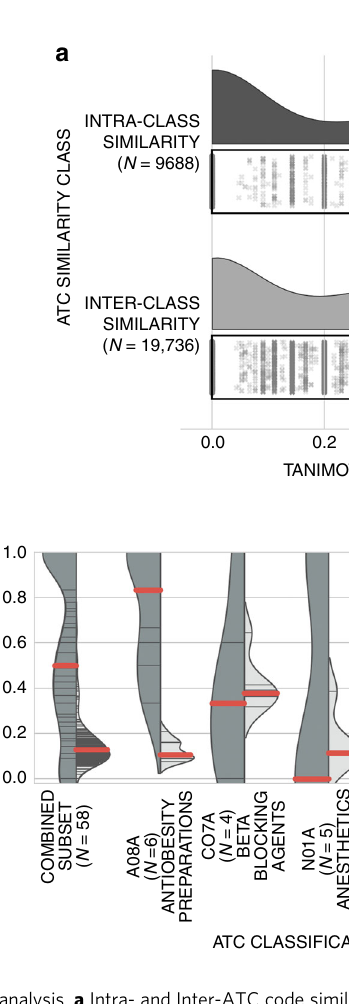
Fig. 2 Neurochemical similarity analysis. a Intra- and Inter-ATC code similarity of neurochemical response patterns across brain regions. Distributions are shown using kernel density estimation (KDE) with median similarities identi fi ed by the red marker and via the underlying boxplot with the notch denoting median, the outer boxes denoting the lower and upper-quartile ranges and the jitter scatter plot outlining the underlying observations. Compounds within the same ATC classi fi cation (intra-similarity) exhibit higher median similarity in neurochemical response than between ATC codes (inter-similarity), with a median response fi ngerprint Tanimoto coef fi cient ’ s of 0.43 and 0.33, respectively. The underlying distributions are statistically different with a two-sided Kolmogorov – Smirnov test p -value of 6.31 e-56 . However, the similarity distributions are quite wide (interquartile ranges span 0.0 to 1.0 for both intra- and inter-similarities), with large overlap. Hence, ATC codes could also be considered to be not very meaningful descriptors of neurotransmitter activities. b Intra-ATC class similarity of the neurochemical and chemical fi ngerprints of compounds for ATC classes with 4 or more representative compounds. The number of compounds underlying each distribution is denoted using ( N = ), with the underlying distribution shown using KDE, the median shown via a solid red line and the underlying observations shown via the black stick markers. Our results highlight there are signi fi cant differences between different ATC classi fi cations. N.B.: Only ATC classi fi cations with N ≥ 4 (~3% of drugs in the database) are shown. The so-called combined subset category shows the distribution of the combined subset across the eight ATC classes shown and number of distinct